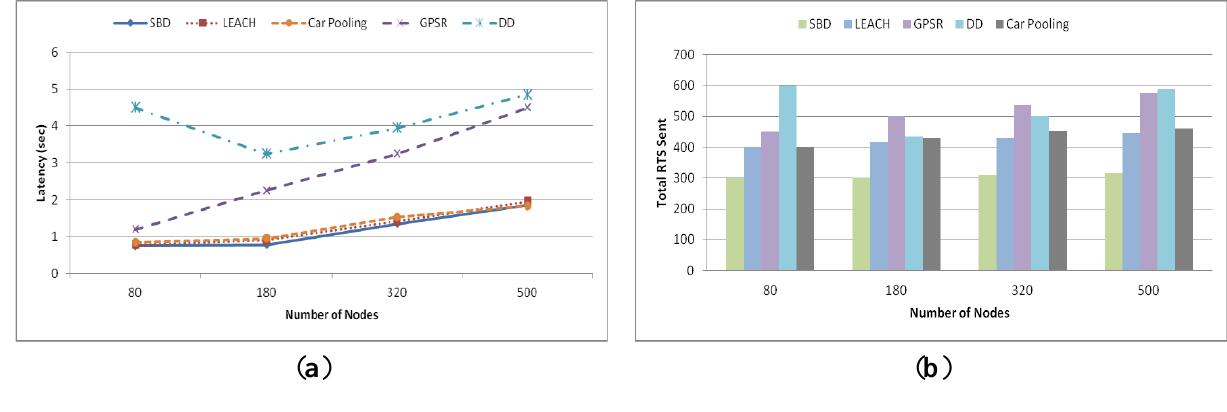
Figure 12. ( a ) Latency (sec) and ( b ) total RTS